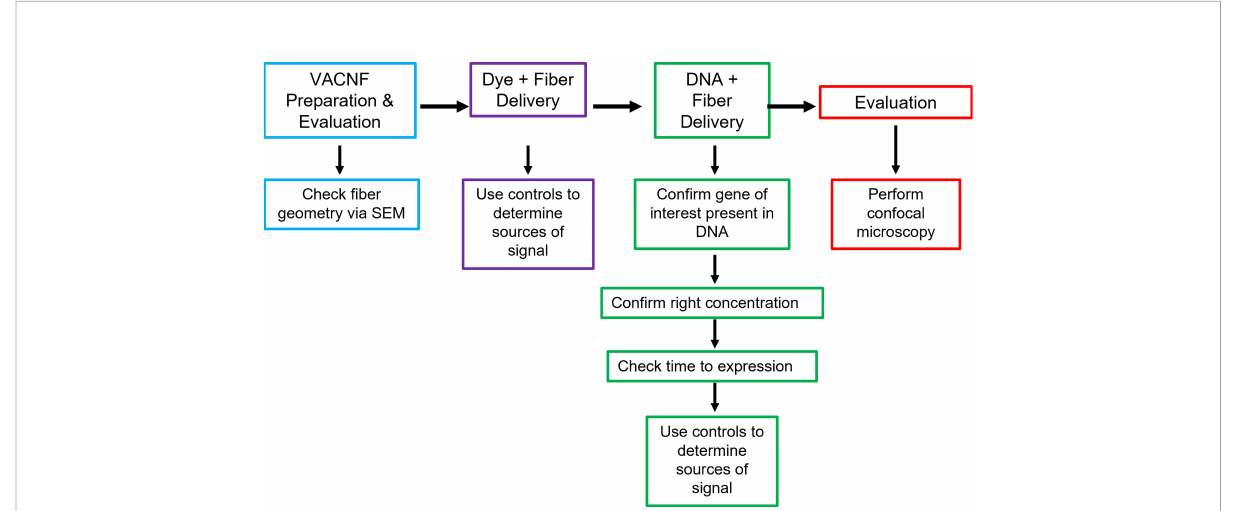
FIGURE 7 Work fl ow for VACNF mediated transient transformation of plants. When using the VACNFs for delivery of small molecules, there are a few problems that can arise. The fi rst step in troubleshooting is to check the geometry of the fi bers using scanning electron microscopy to ensure that the fi bers are straight and have a sharp tip. After con fi rming the fi ber geometry, the next step is to make sure that you are able to successfully deliver dye into your plant/organ of choice. For this purpose, place a 1 m L droplet on the plant surface and use the fi bers to deliver the dye, checking for delivery with the microscope. With this step and all other steps moving forward, it is important to use appropriate controls ( − dye, − fi bers; − dye, + fi bers; and +dye, − fi bers), to be con fi dent that you are getting signal from dye delivery. If both steps are successful, the next step would be to ensure that your gene of interest is present in your plasmid, you are using the right concentration of DNA, and you are waiting the right amount of time after delivery to check expression. The last step is to check expression using confocal